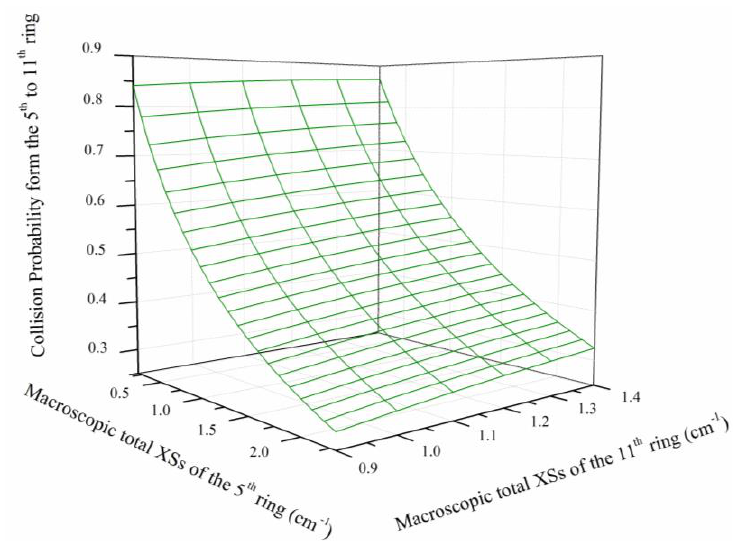
Figure 2. Macroscopic hyperfine group total cross sections of a gadolinia rod in VERA